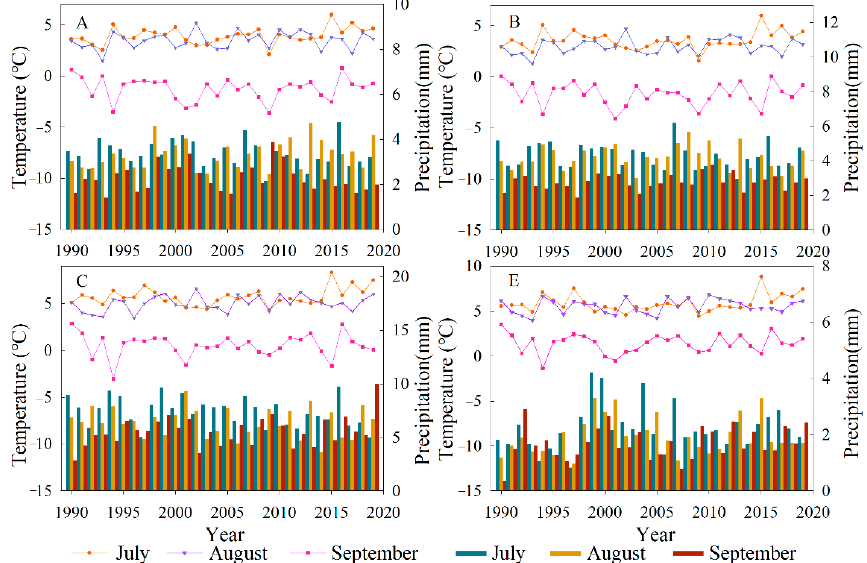
Figure 14. Change of temperature and precipitation in July, August, and September of glacial advance in the Tien Shan (the line graph shows the temperature, and the bar graph shows the precipitation; ( A – C , E ) in the figure correspond with locations in Figure 4; data from ERA5-Land Climate Reanalysis dataset).